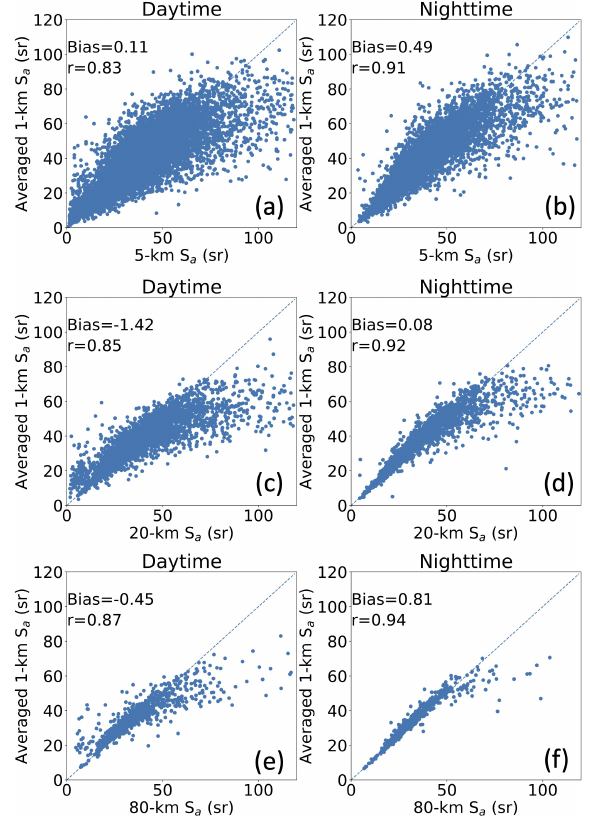
Figure A1. Average-then-retrieved versus retrieved-then-average methods for lidar ratio. Intercomparison between lidar ratio re- trieved using attenuated backscatter horizontally averaged to 5, 20, and 80km along-track grid size, and lidar ratio derived using 1km averaged attenuated backscatter, and further averaged to match the 5, 20, and 80km resolution. Data points are showed for samples for which at least 50% of 1km retrievals were successfully computed for a given spatial